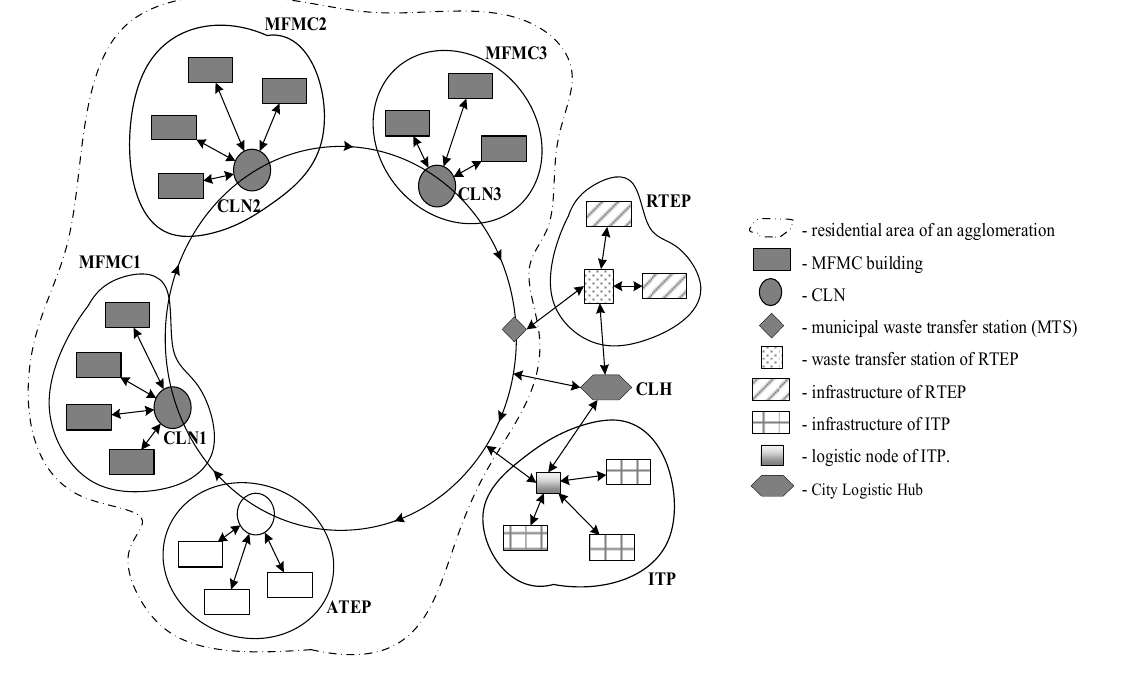
Figure 1. Material flow in SCs of the MFMC.